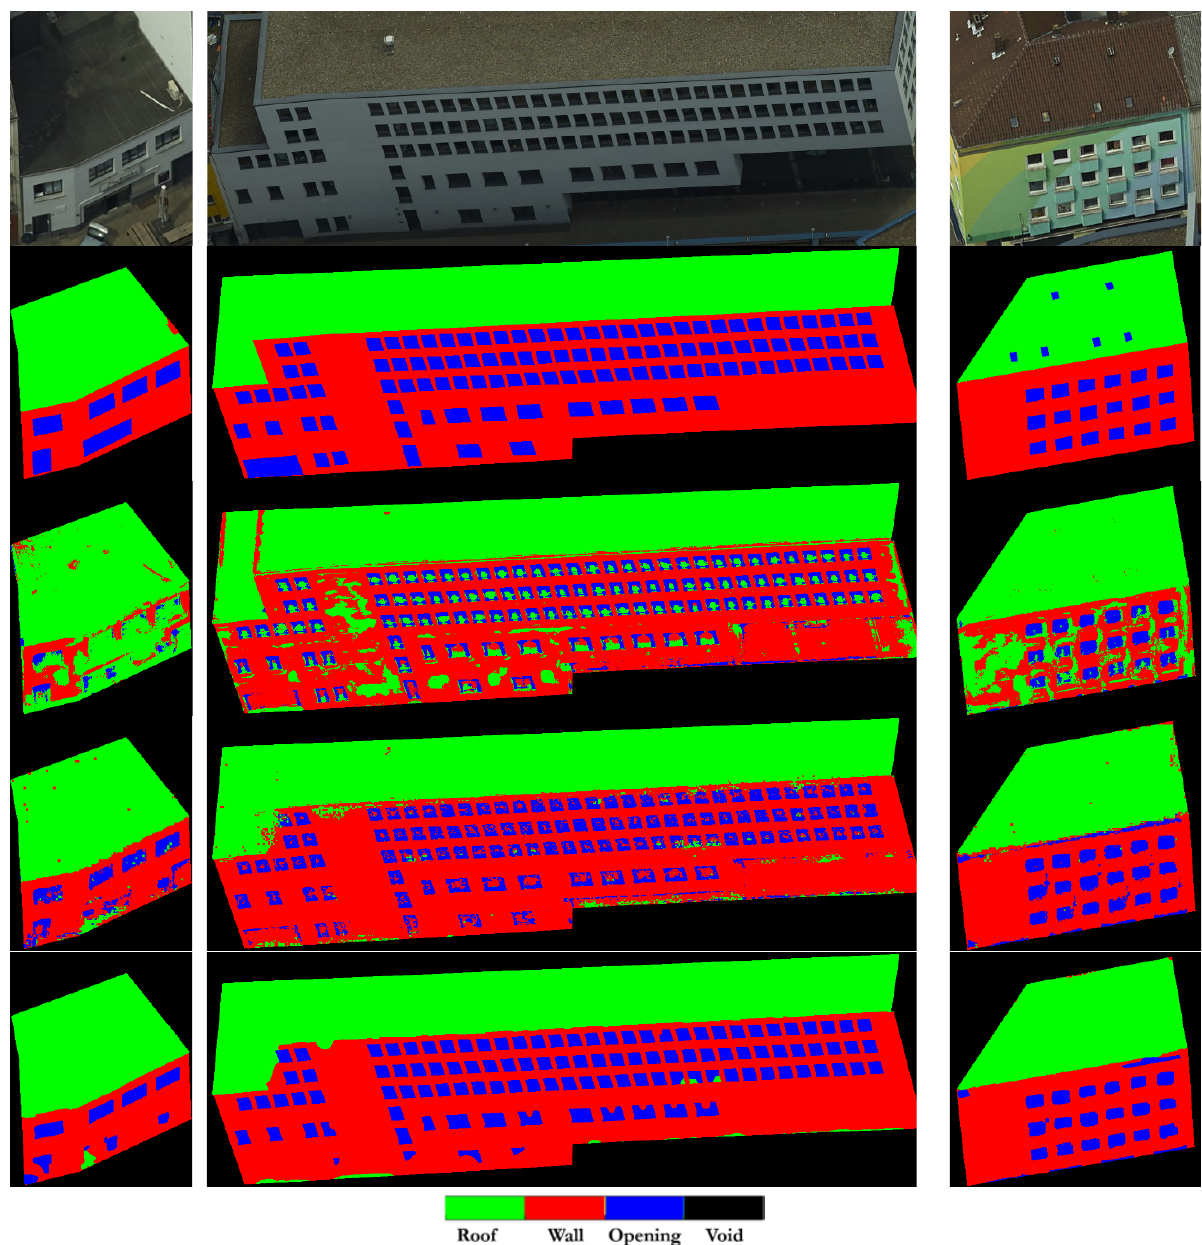
Figure 6 Examples from our dataset. First row: cropped façade images from oblique aerial images. Second row: ground truth. Third row: results from random forest using 2D features. Fourth row: results from random forest using 2D and 3D features. Fifth row: results from fully connected CRF and the unary term is obtained from random forest using 2D and 3D